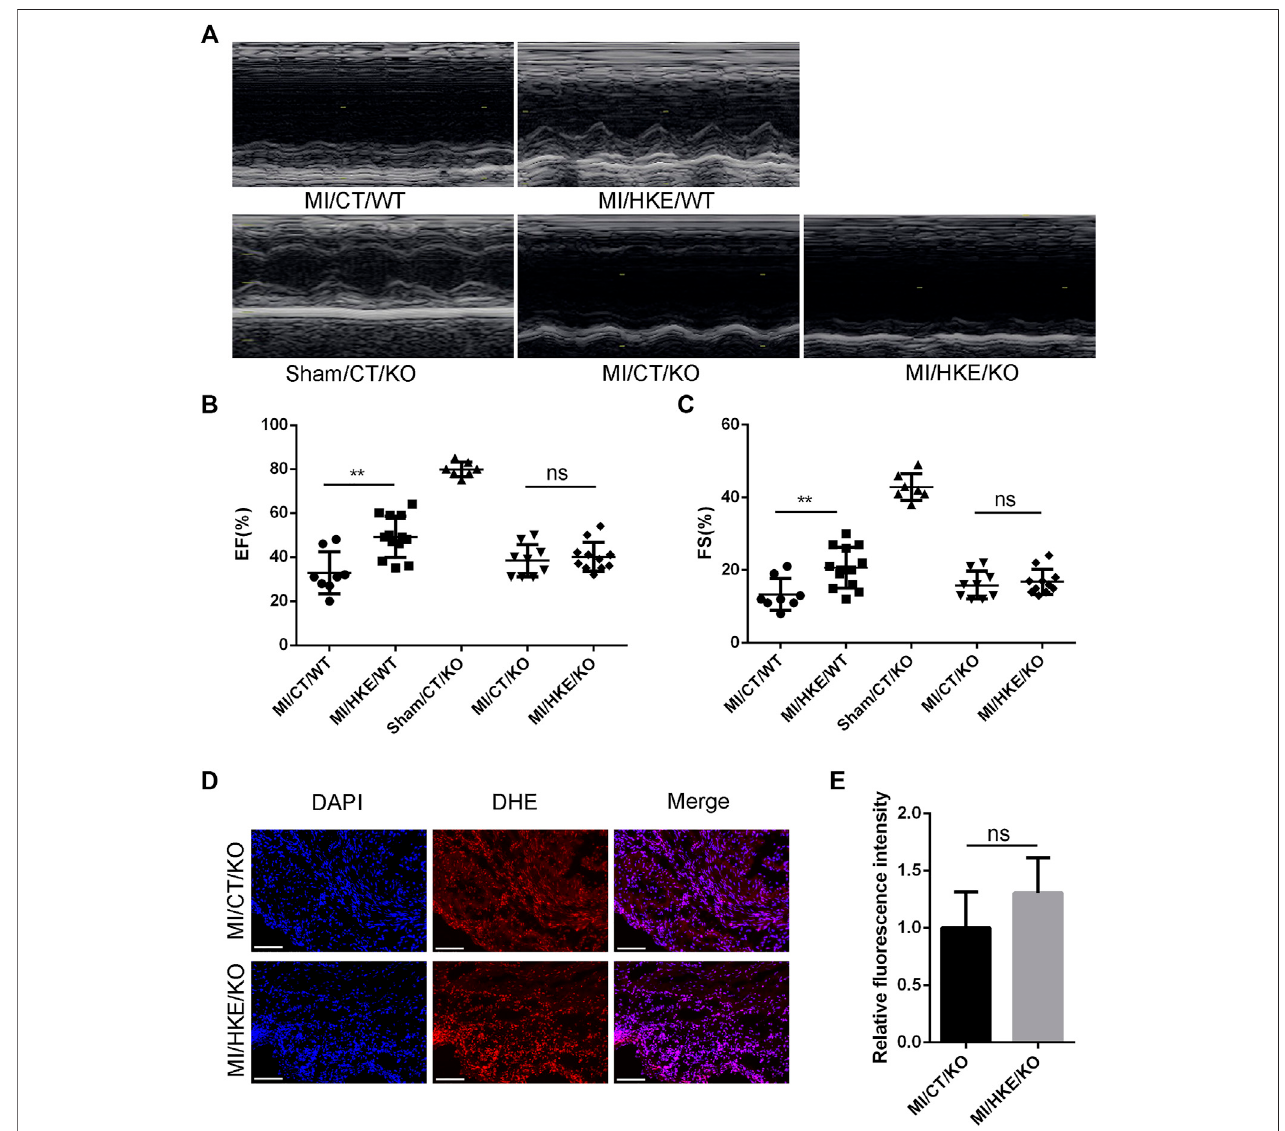
FIGURE 7 | Ucp3 mediates the protection of HKE against post-MI HF. Construction of MI model with Ucp3 knockout and WT mice,4 weeks after MI, EF and FS were determined by echocardiography (A – C) . Heart slides were stained with DHE to analyze the production of ROS in situ, scale bar: 100 μ m (D) . The fl uorescence intensity was measured using ImageJ software (E) ( n = 3 per group). Values are shown as means ± SD, * p < 0.05 , ** p < 0.01 , ns: no signi fi cance.